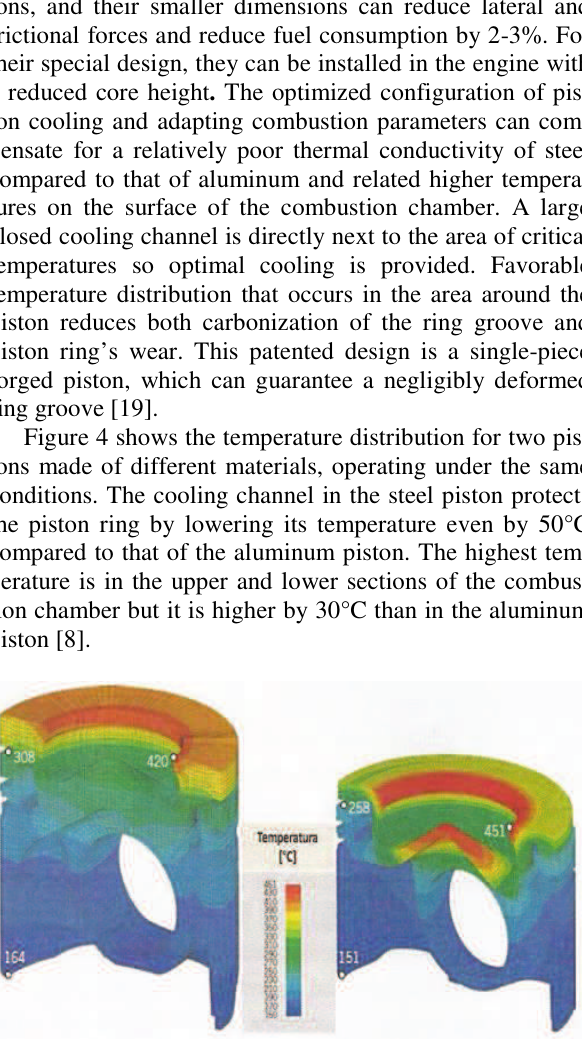
Fig . 4. Distributions of temperature in aluminum and steel pistons [8]